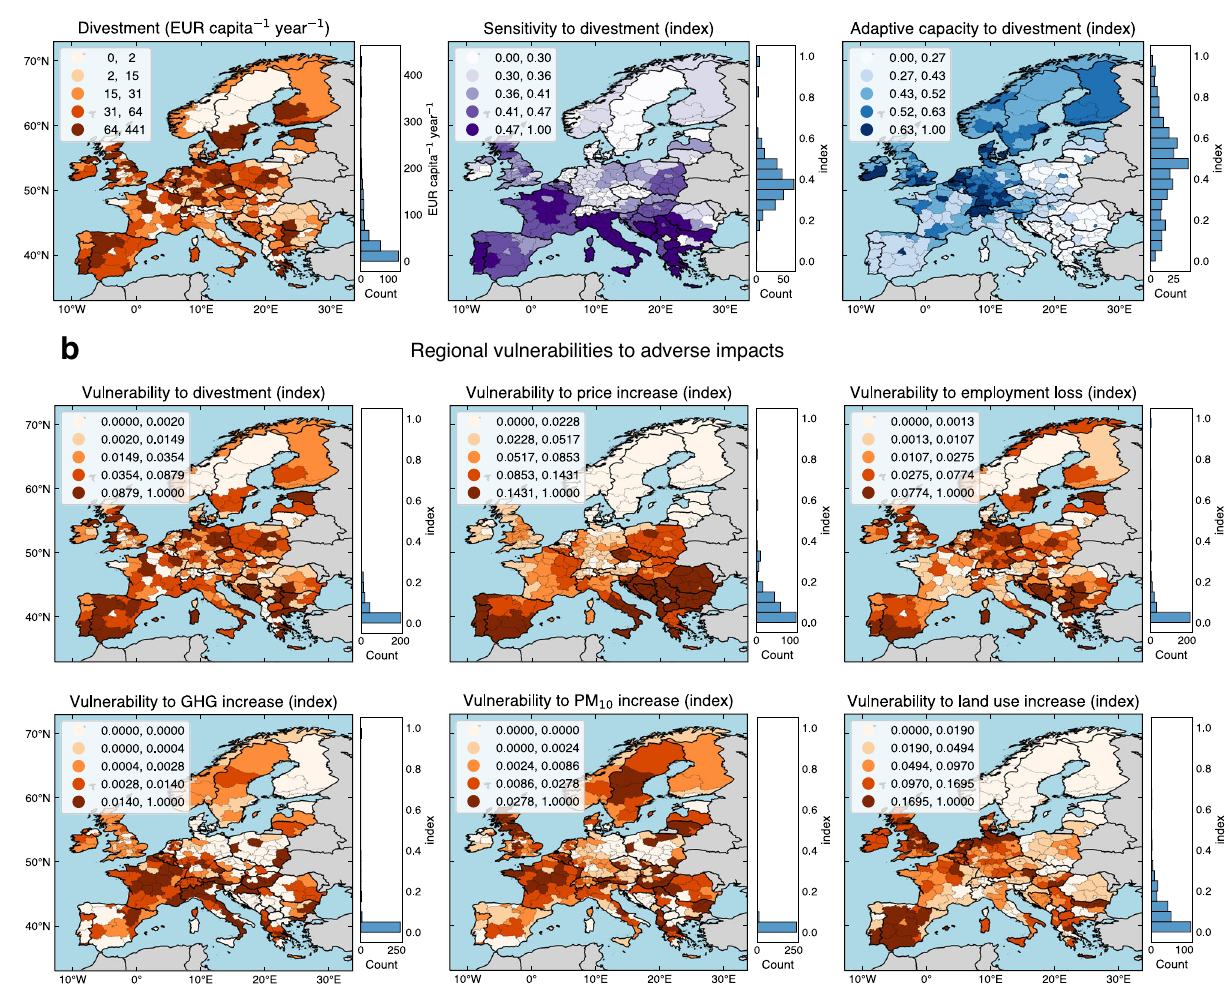
Fig. 4 | Maps of scenario averages of regional electricity sector vulnerabilities in 2035. a An illustrative example of disaggregated vulnerability calculation for divestment associated with the electricity sector. Regional vulnerability combines scenario averages of modeled adverse impact (divestment) with indicators of regional sensitivity and adaptive capacity to divestment. The left map shows the average regional electricity sector divestment across 248 MGA scenarios and the minimum cost scenario as compared to the scenario of frozen generation and storagecapacity. b Mapsofregionalvulnerabilities(indices)forsixtypesofadverse